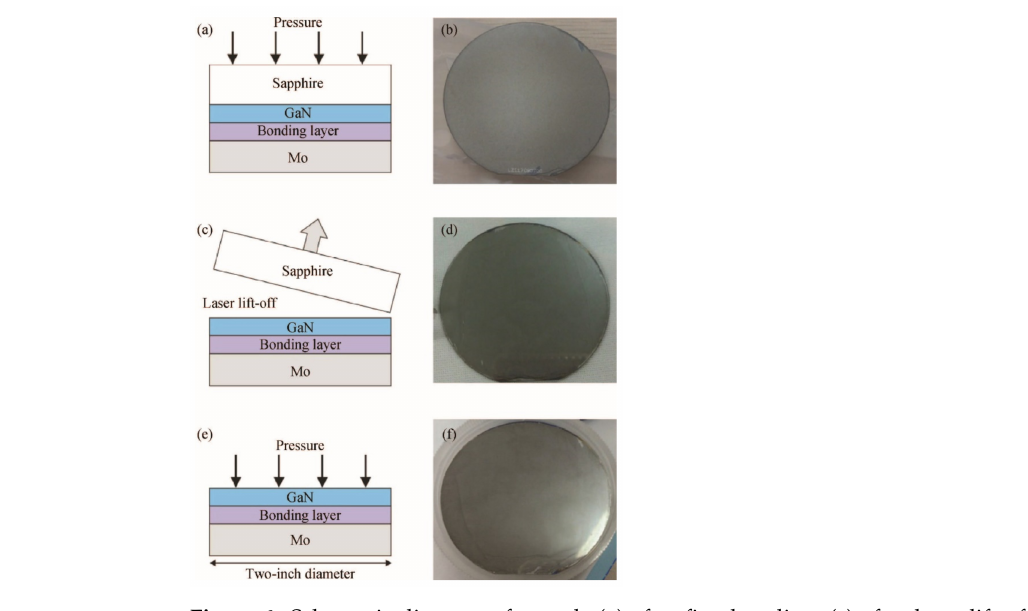
Figure 6. Schematic diagram of sample ( a ) after first bonding, ( c ) after laser-lift-off, and ( e ) after second bonding; image of the 2-inch-diameter sample after it went through ( b ) first bonding, ( d ) laser- lift-off, and ( f ) second bonding. Adapted with permission from [181]. Copyright IOP Science,